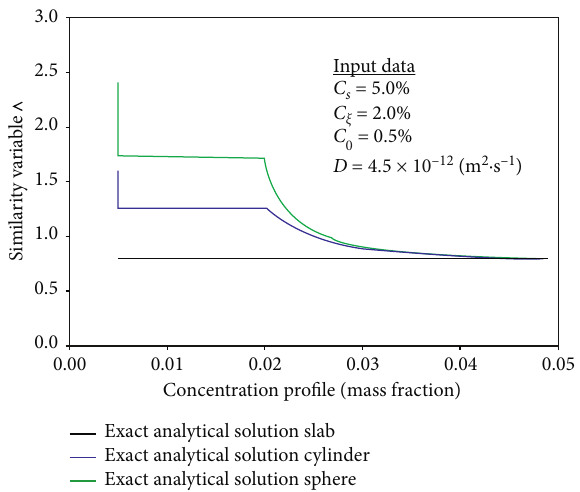
Figure 16: Comparison between numerical and analytical solu- tions for diffusion times during inward diffusion of a slab, a cyl- inder, and a